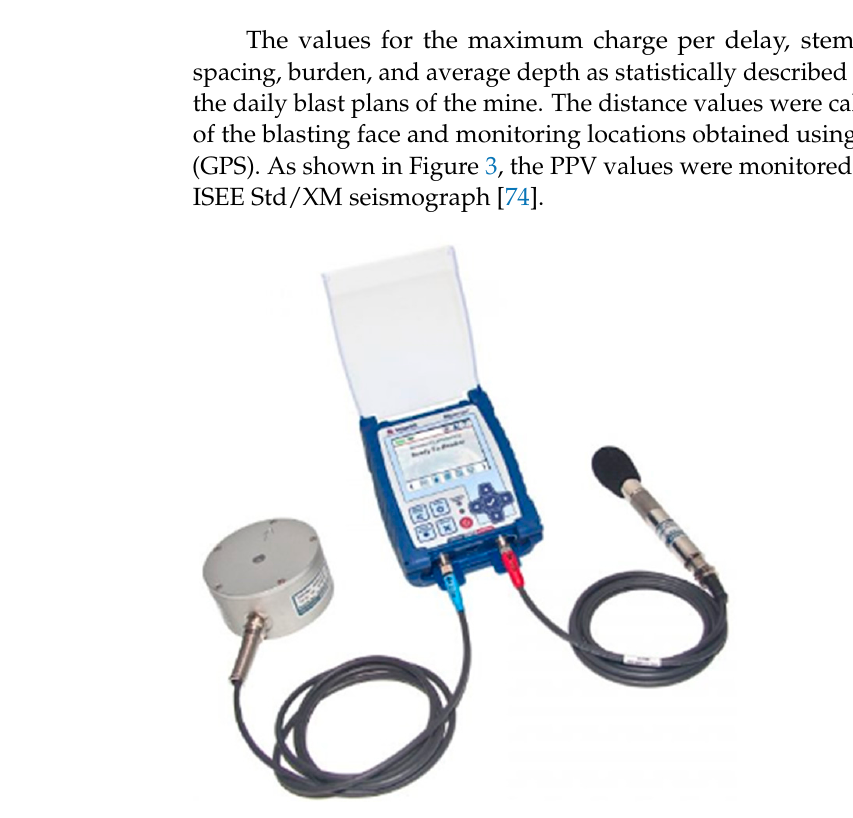
Table 4. Description of dataset parameters.